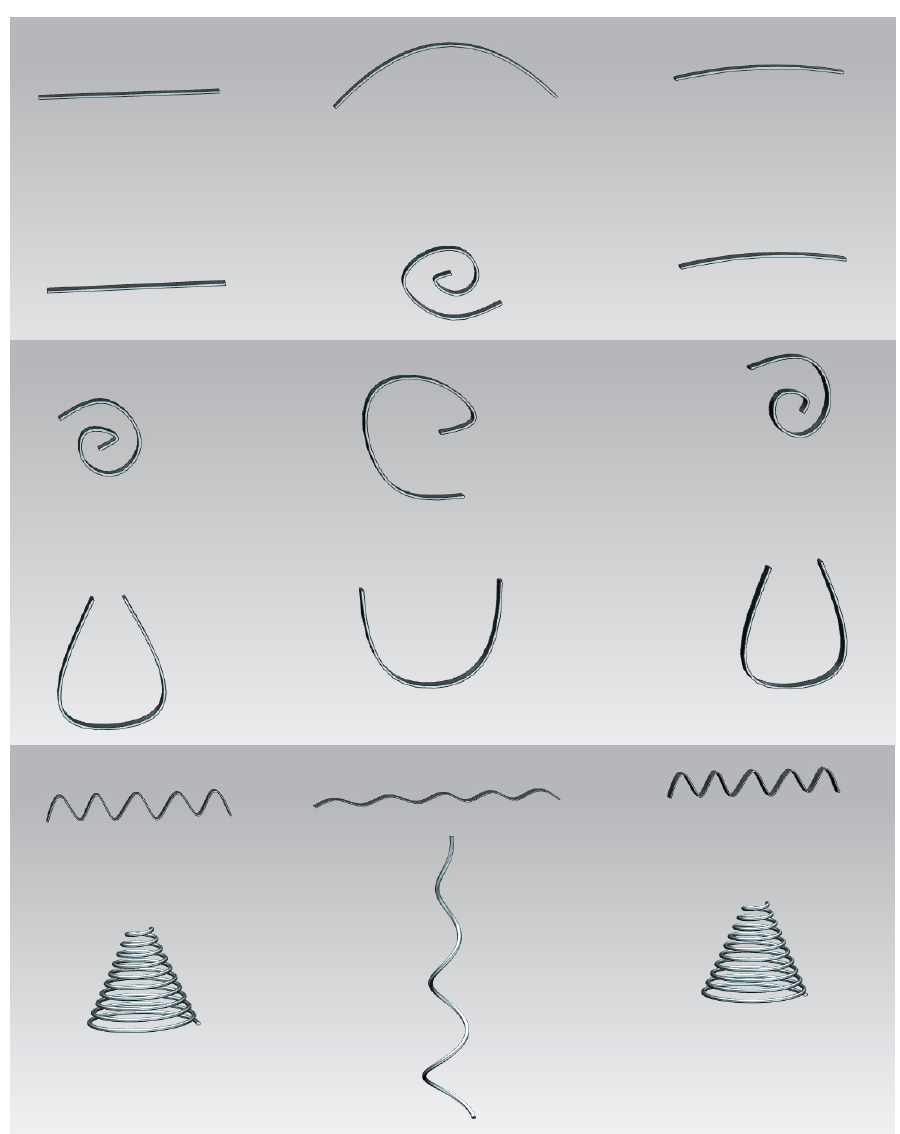
Figure 2. Summary of typical conceptual geometries for reliable actuators based on shape-memory polymers. The left column includes the original geometries, the central column includes the temporary shapes after training and the right column shows the finally recovered shapes.